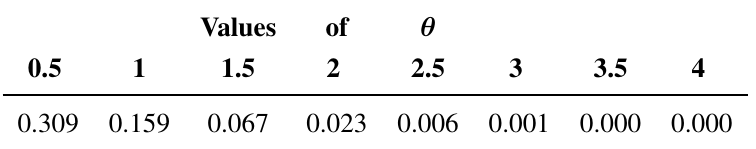
Table 6. Probability of a normal variable having negative